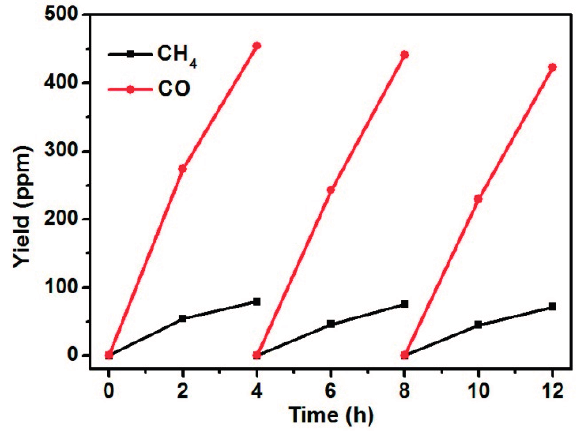
Figure 6. The cycling test of CO 2 photoreduction over 12 h by using the MEA–ZnO